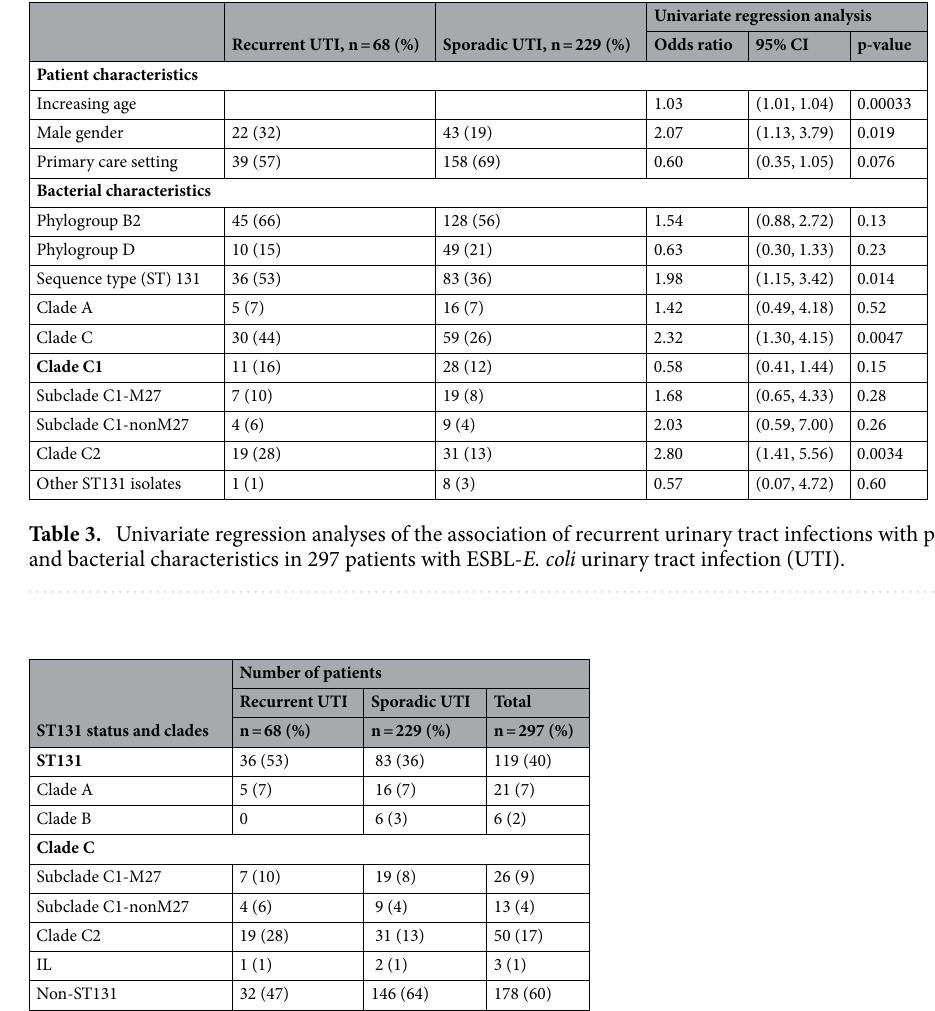
Table 4. Sequence type (ST) 131 status for the index ESBL- E. coli isolates in 297 patients with recurrent or sporadic urinary tract infection (UTI).